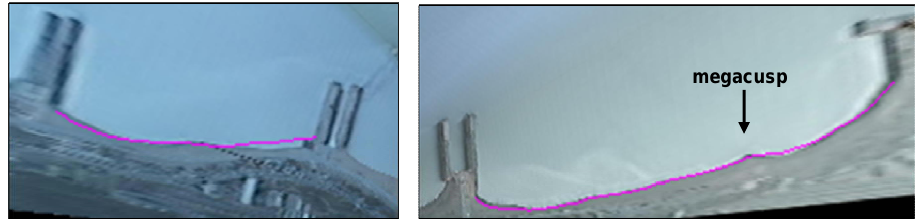
Figure 2. Deep-water wave conditions off Barcelona from November 2001 to March 2006 (from top to bottom, significant wave height, peak period, and approaching wave direction). Green dots indicate the major 25 storms analyzed. Storm conditions are predominantly from the East.